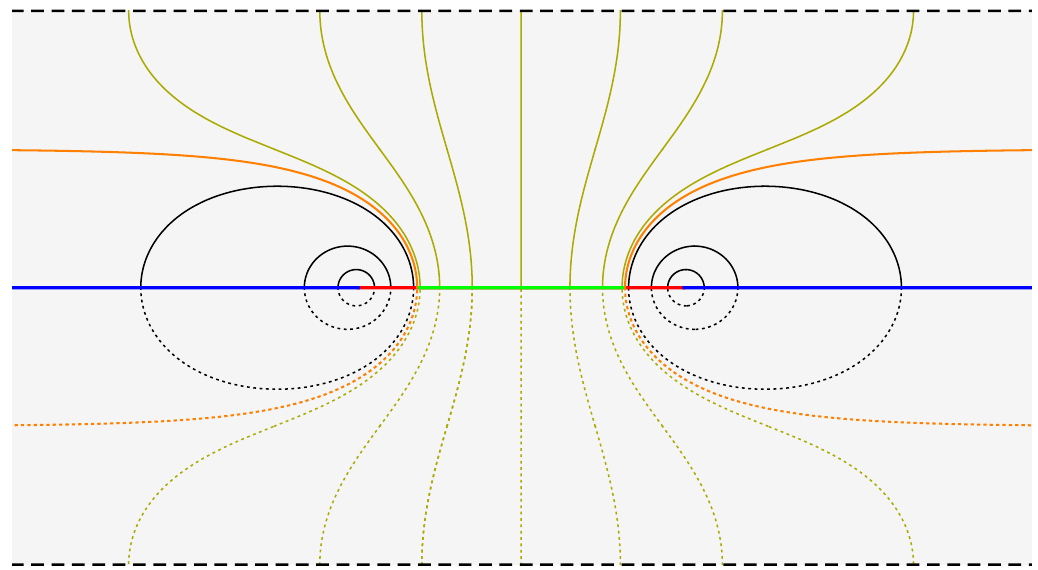
Figure 5 . Euclidean modular evolution for a CFT at finite temperature 1 /β on the bipartite line, obtained from (5.2), with θ ∈ (0 , π ) (solid arcs) or θ ∈ ( π, 2 π ) (dotted arcs), for some x ∈ A . The green segment corresponds to A β . The solid black curves (or the dotted black ones equivalently) map A \ A β into B in a bijective way, while the solid yellow curves (or the dotted yellow ones equivalently) map A β into the horizontal dashed black line at Im ( z ) = + β/ 2 (which is identified with the horizontal dashed black line at Im ( z ) = − β/ 2 ) in a bijective